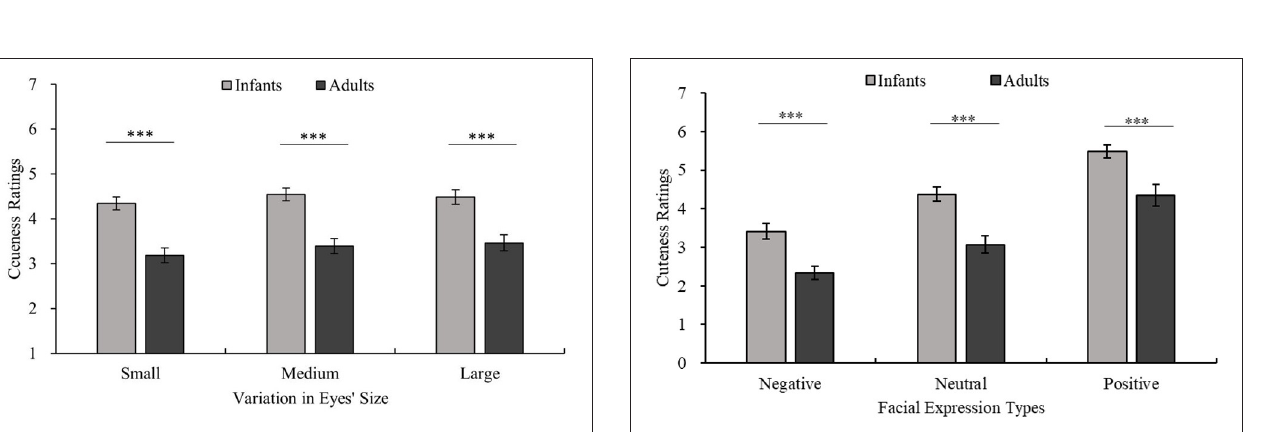
expression main effect F (1.59,34.89) = 51.85, p < 0.001, η 2 =